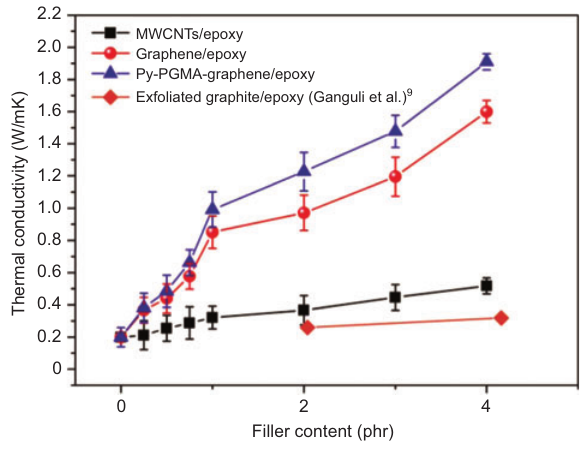
Figure 13 Thermal conductivity with various fi ller contents of MWNTs/epoxy, graphene/epoxy, and Py-PGMA-graphene. (Reproduced from Ref. [106] with permission from Elsevier